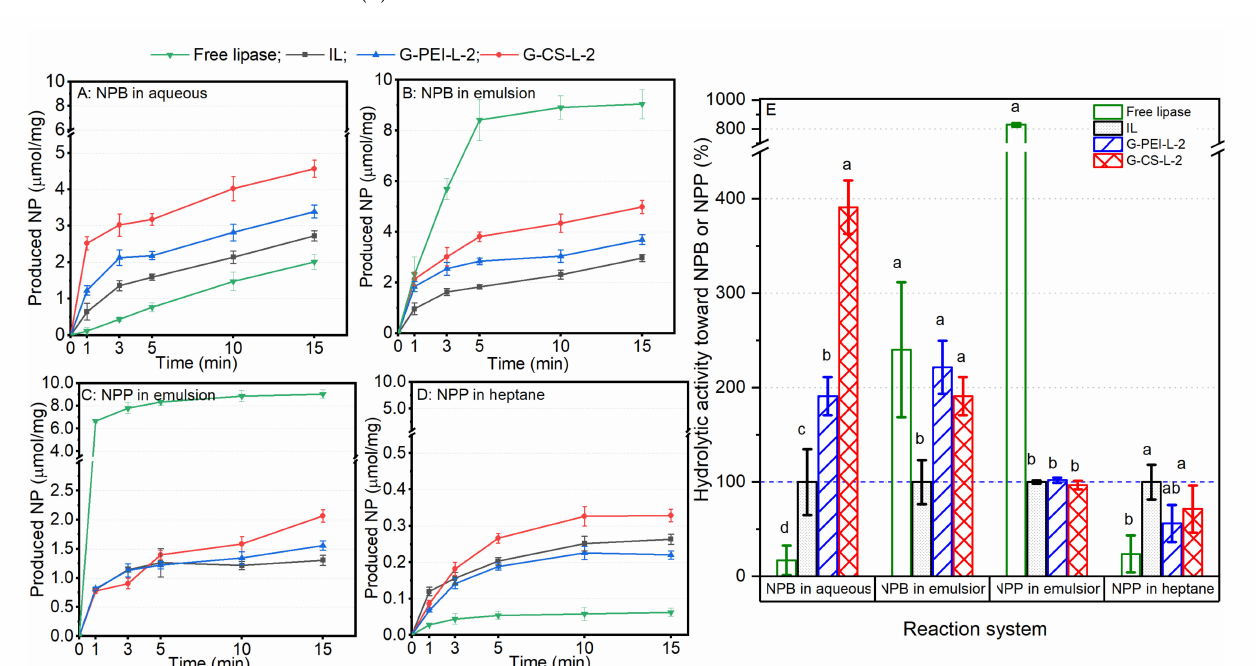
Figure 7. The hydrolysis of p-nitrophenyl butyrate (NPB) in an aqueous solution ( A ) and in an emulsion ( B ); the hydrolysis of p-nitrophenyl palmitate (NPP) in an emulsion ( C ) and in heptane ( D ). The initial hydrolytic reaction rate (within the first 1 min) was calculated as hydrolytic activity and the activity of IL was taken as 100% ( E ). The hydrolytic capacity was described by the amount of NP produced per milligram of dried immobilized lipase preparations or dried lipase powder (free form). Different lowercase letters in ( E ) indicate significant differences among the applied biocatalysts for each reaction system ( p <